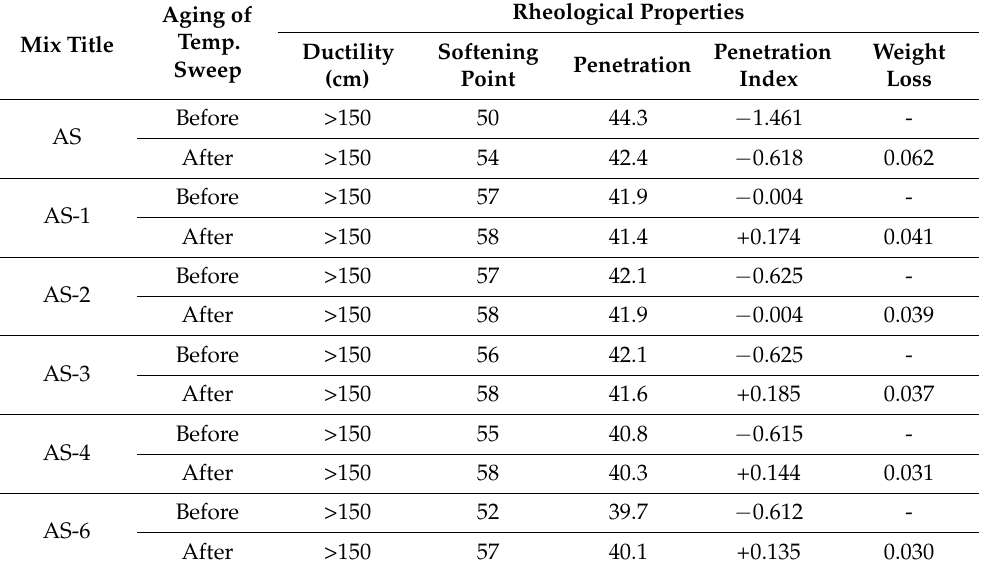
Table 6. Temperature sweep of PW and ULO-modified asphalt pastes.